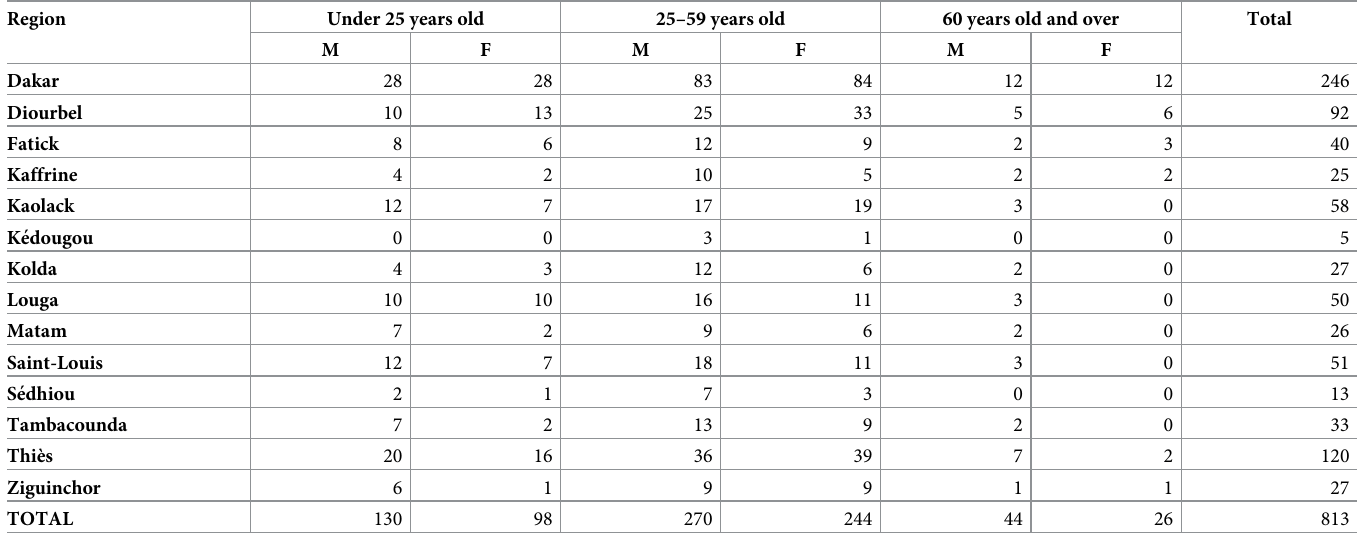
Table 1. Characteristics of the quantitative sample (n = 813).